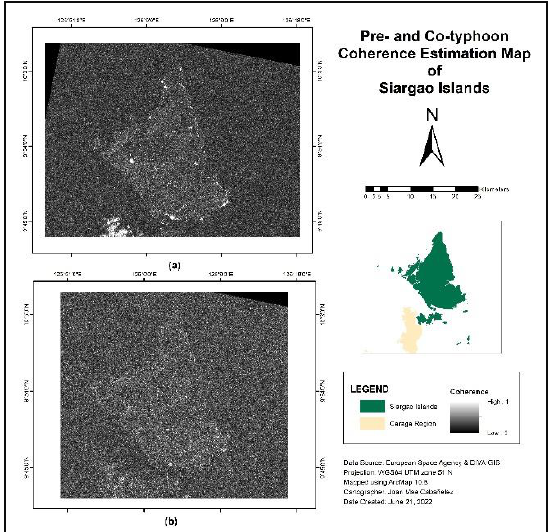
Figure 4 . Pre-typhoon and Co-typhoon Coherence map of Siargao Islands